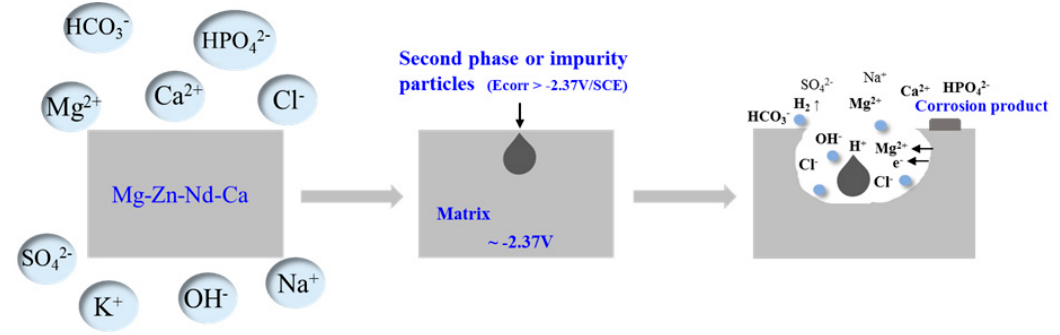
Figure 11. Schematic diagram of the corrosion process of Mg-6Zn-0.5Nd-xCa alloys.